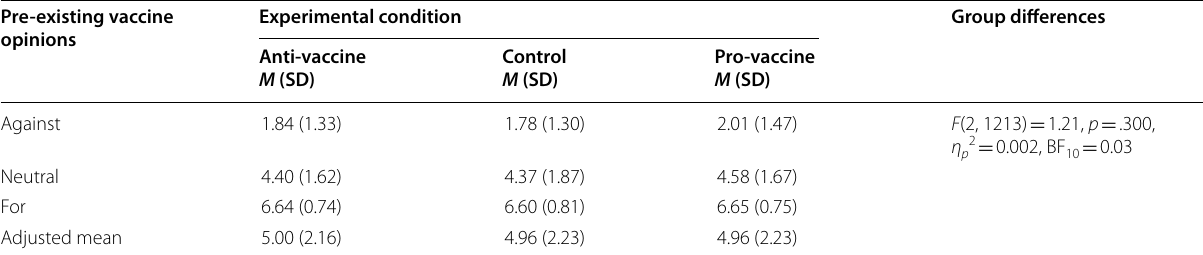
Table 1 Effects of misinformation exposure on vaccination intentions in Study 1, controlling for pre-existing opinions